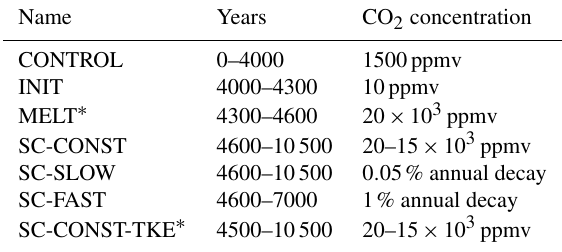
Table 1. Prescribed CO 2 forcings for the set of simulations pre- sented in this study. In scenario SC-CONST the CO 2 concentra- tion is reduced stepwise to 18, 17, 16 and 15 × 10 3 ppmv in years 4800, 6400, 7600 and 7940 to avoid model instability at tempera- tures that are too high. Similarly, there are stepwise reductions to 17 and 15 × 10 3 ppmv in years 4600 and 7290 in